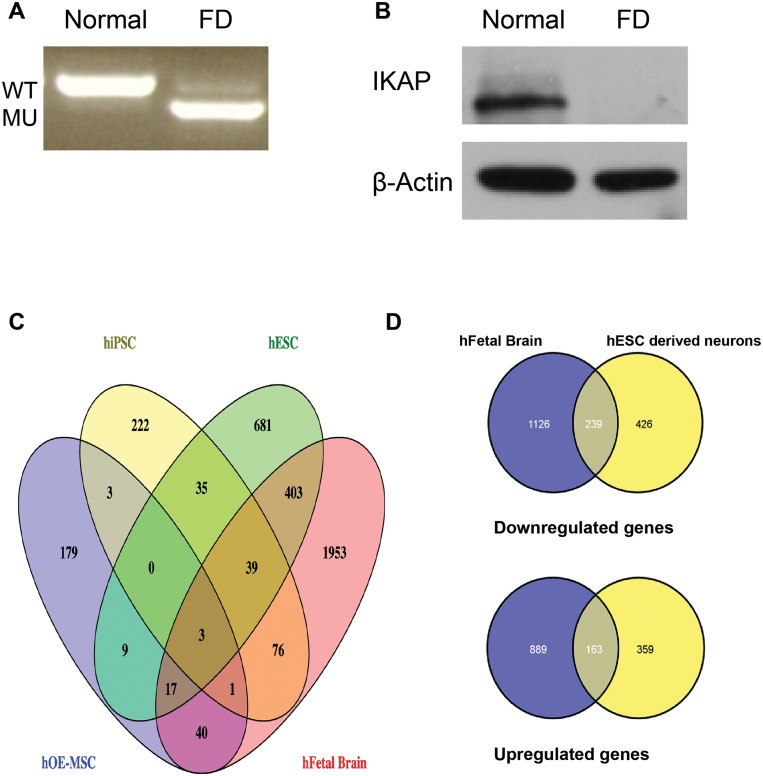
Comparative transcriptome analysis between human 12 weeks fetal WT and FD brains to WT and FD hESC derived neurons.Prior to cDNA microarray chip analysis mRNA and protein extracts from the brain samples were used to validate the FD phenotype of the FD splicing mutation in the IKBKAP gene at the transcriptional and translational levels by: (A) RT-PCR analysis of the expression of IKBKAP in human 12 weeks fetal WT and FD brains showing WT (upper lane) and FD (mis-spliced, lower lane) mRNA isoforms in the FD brain only. (B) Western blot analysis of IKAP protein levels in WT and FD brains. Note the almost complete absence of IKAP in the FD brain. β-Actin served as loading control. Comparative transcriptome analysis between data obtained from both cDNA microarray chips of WT and FD fetal brains and hESC-derived PNS neurons was performed by cross-referencing genes which their expression levels differ significantly (>2 fold) between FD and WT. (C) Venn Diagram representation of a wide genome transcriptome analysis of common genes that are differentially expressed in FD-hESC-derived PNS neurons (in green) and in two other known FD stem cell neural-derived models (FD fibroblasts derived iPSC (in yellow) [23] and FD-hOE-MSC (in blue) [24] and in FD Fetal brain (in red). Cross-referencing genes with their expression levels difference of >2 fold change for hESC p<0.05 or >1.5fold change p<0.05 for iPSC and hOE-MSC between WT and FD were considered for analysis. The number at the crossection between the diagrams represents the number of genes that are shared by these multiple analyses. For the list of genes see S3 Table. (D) Gene sets were divided into downregulated and upregulated genes in both hESC-derived PNS neurons and Fetal brain biological systems. Venn diagram represents the results from this analysis showing in blue, the number of genes that differ in WT and FD in the fetal in vivo and in yellow, the number of genes that differ in WT and FD hESC derived neurons in vitro. The crossection between the diagrams represent the number of genes that are shared by both analyses. Upper diagrams represent the downregulated genes while the lower ones represent the upregulated genes.